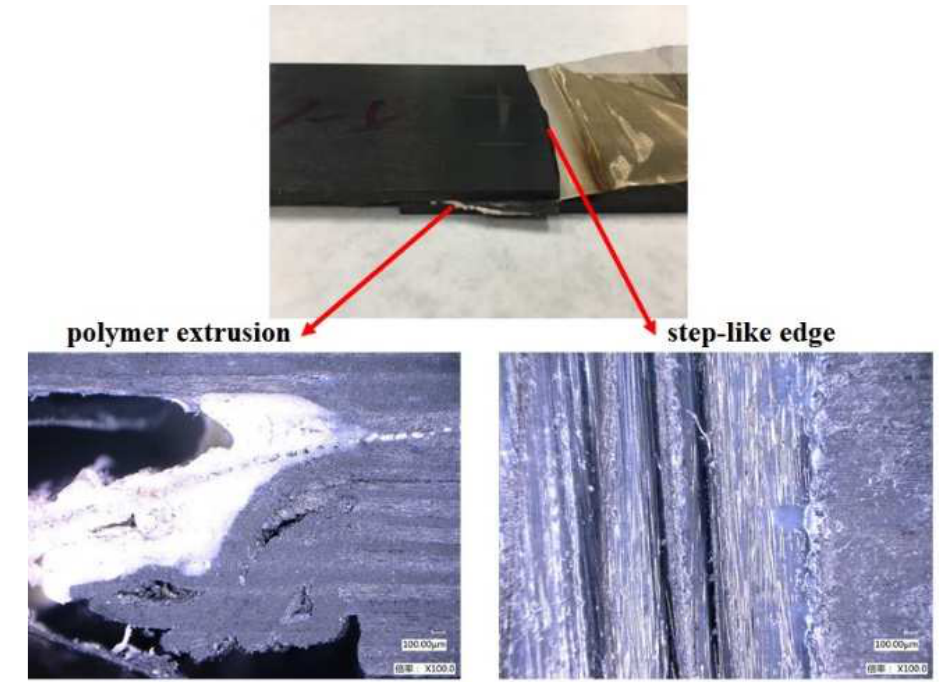
Figure 7. Morphology of weldment obtained with type B heating element at 74 kW/m 2 power den-